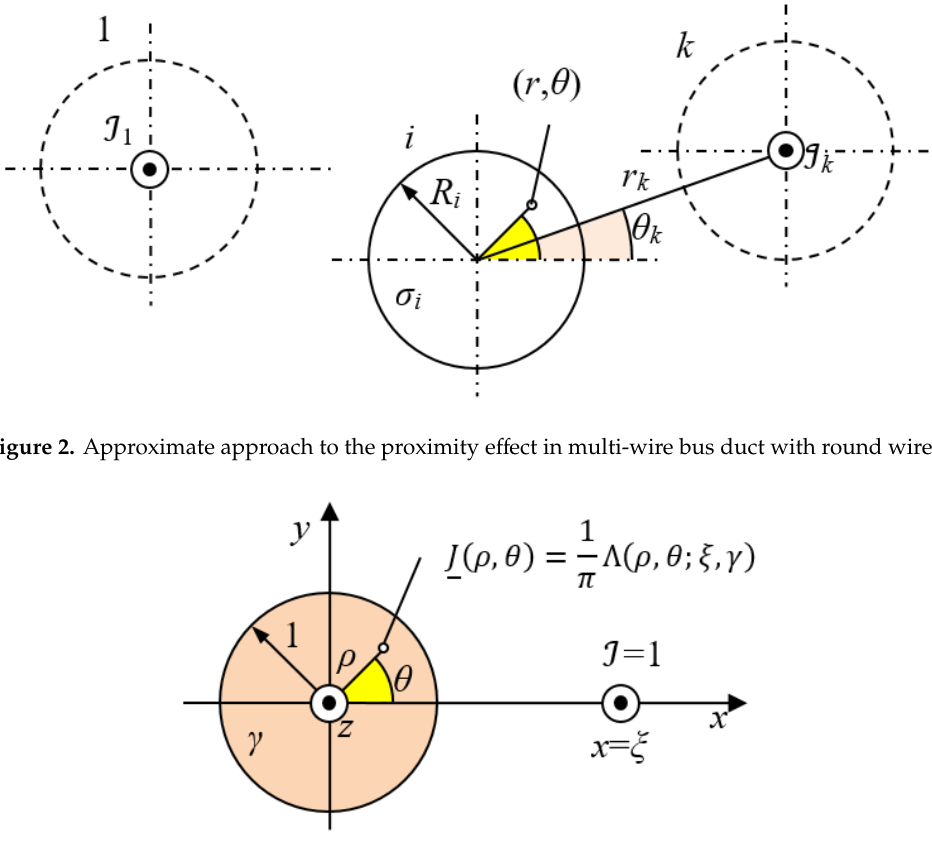
Figure 3. Interpretation of function Λ .